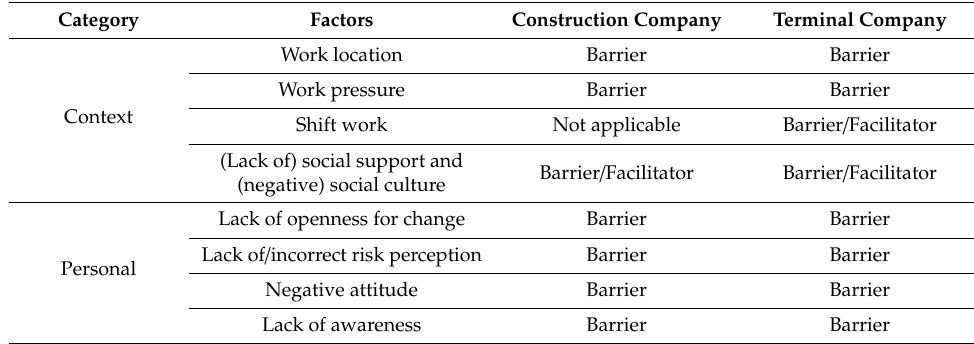
Table 1. Barriers and facilitators for a citizen science approach to improve health at the